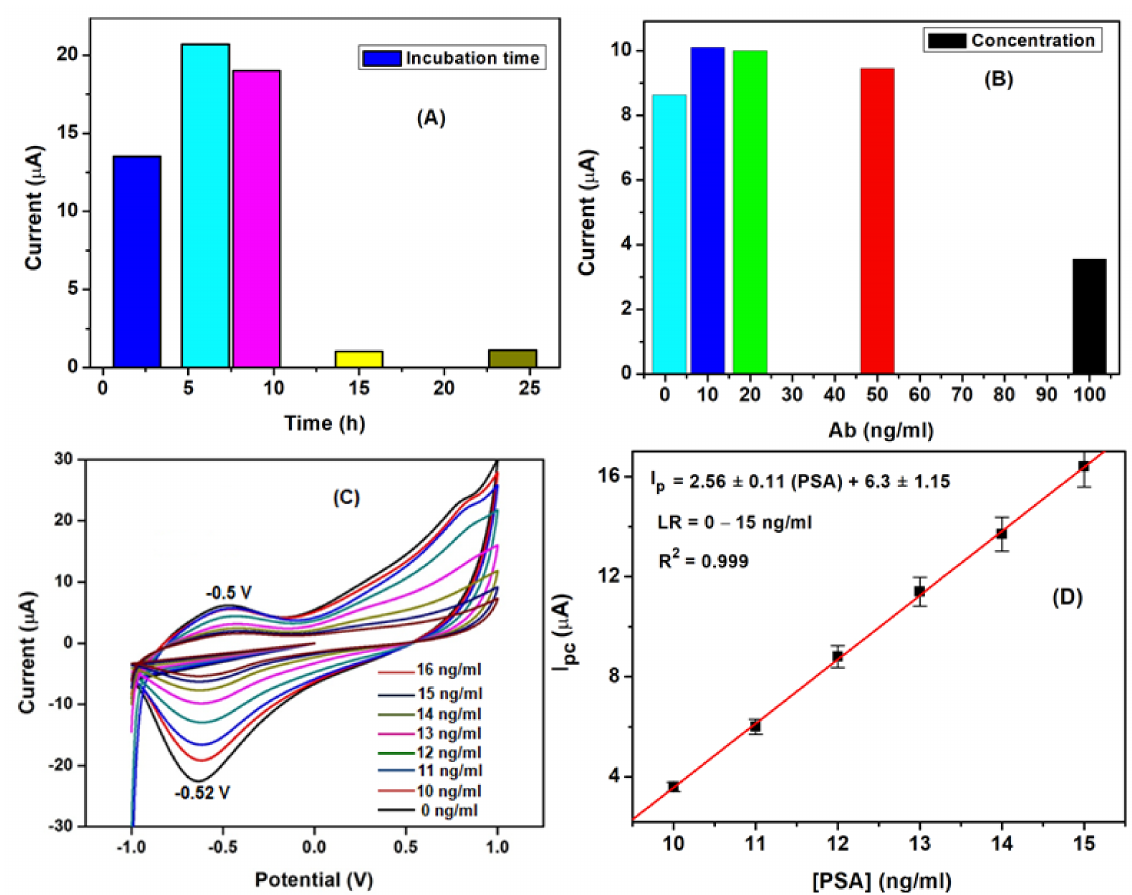
Figure 7. ( A ) Incubation time responses (i.e., CV cathodic peak currents at 20 mV/s) for the formation of Ab|TGA- OsTe 2 QD|PPy|GCE immunosensor electrode with 5 µ L of 20 µ g/mL Ab in 0.1 M PBS pH 7. ( B ) Ab concentration dependence of the Ab|TGA-OsTe 2 QD|PPy|GCE immunosensor electrode responses (i.e., CV cathodic peak currents at 20 mV/s) for 1–100 ng/mL Ab and 6 h incubation time in 0.1 M PBS pH 7. ( C ) CV responses of the PSA immunosensor at 20 mV/s, in 0.1 M PBS pH 7. ( D ) Linear calibration of the PSA immunosensor (i.e., BSA|Ab|TGA-OsTe 2 QD|PPy|GCE) plotted with peak current values obtained from ( C ) at − 0.52 V (standard errors of triplicate experiments are represented by error bars).